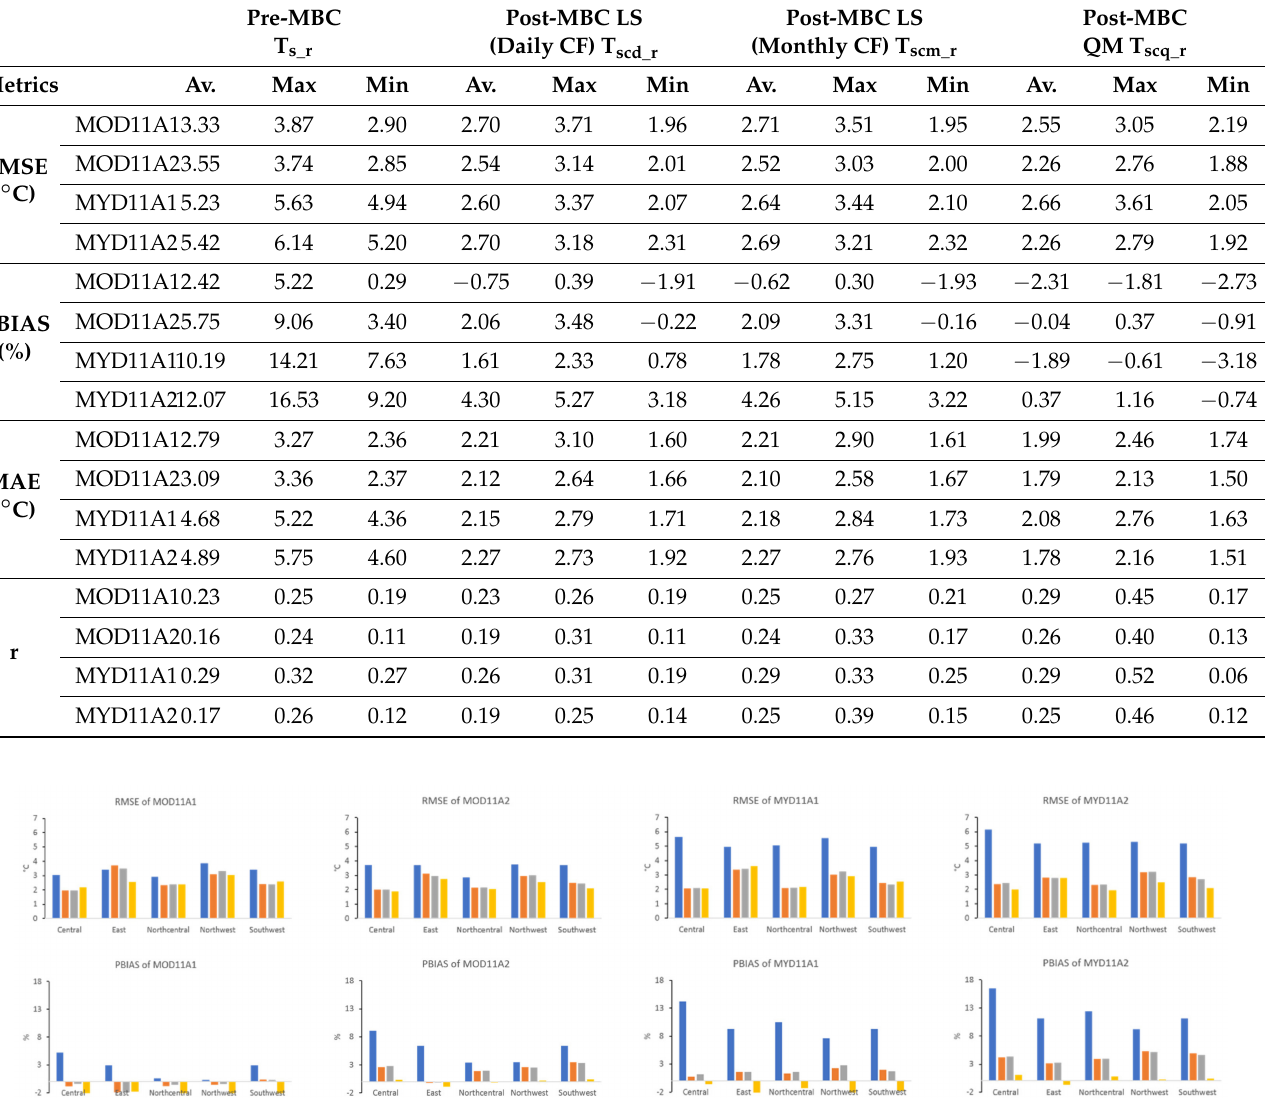
Table 4. RMSE, MAE, PBIAS, and r from by region comparison for pre-MBC (T s_r ), post-MBC linear scaling using constant